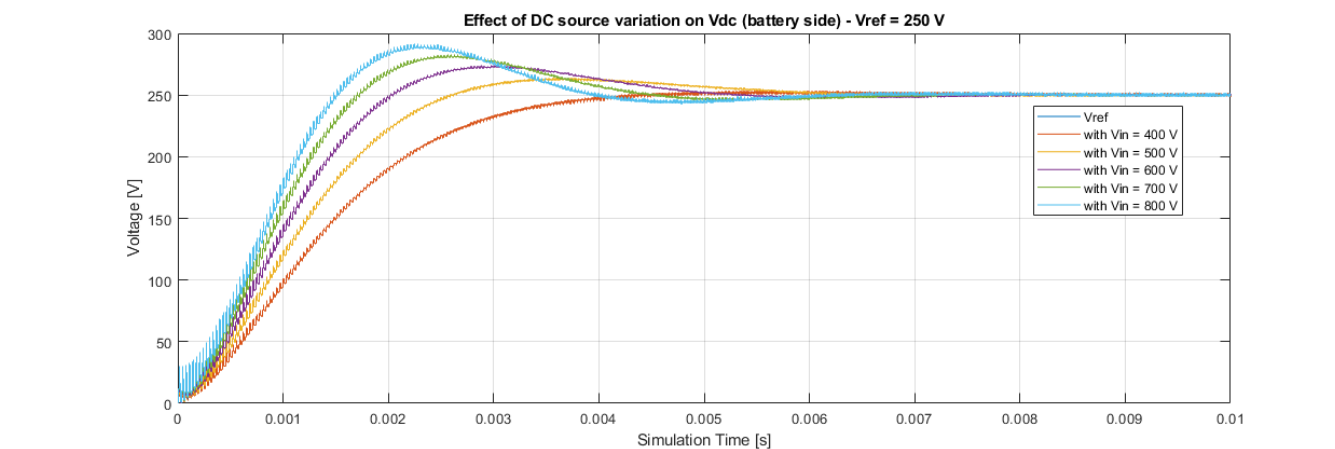
Figure 21. Current control robustness analysis of Totem Pole: effect of L variation ( upper ); effect of C variation ( lower ).